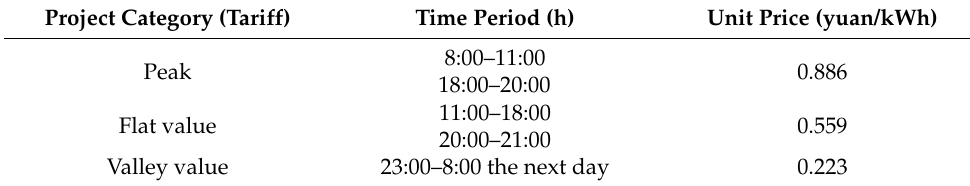
Table 2. Peak and valley period electricity